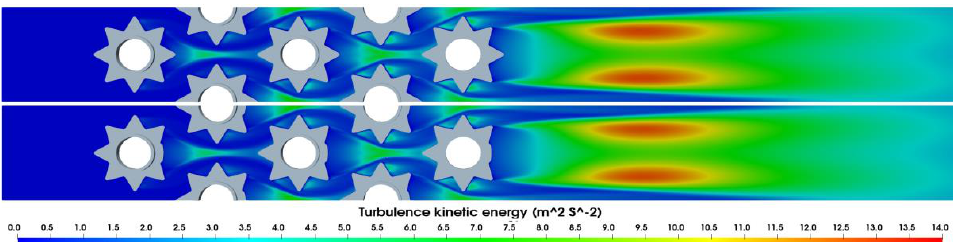
Figure 8. Turbulent kinetic energy fields for star-shaped fins and trimmed fins.